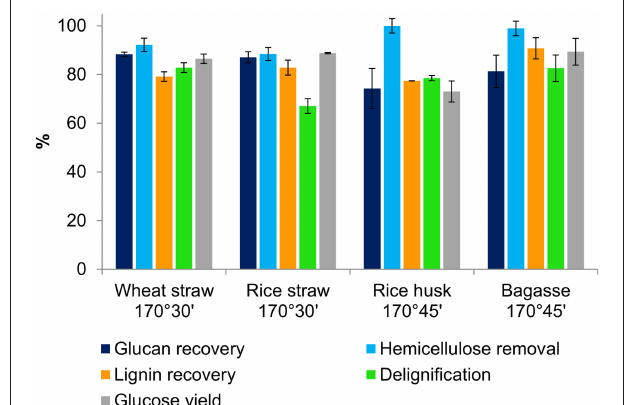
FIGURE 2 | Comparison of key pretreatment parameters for agricultural residues following Ionosolv pretreatment with [TEA][HSO 4 ] under optimized